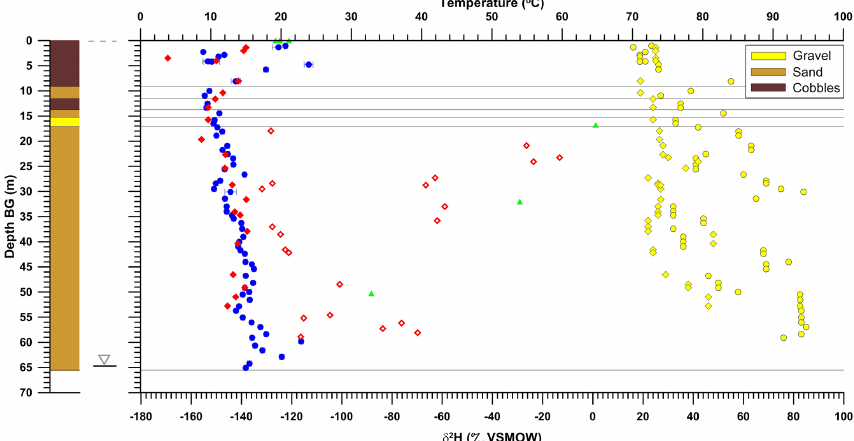
Figure 6. δ 2 H depth profiles of pore water from an unsaturated waste rock pile located in the Elk Valley, British Columbia. Samples collected via dry sonic coring are represented by solid blue circles, collected via wet sonic and not showing evidence of contamination (or minimally so) are represented by solid red diamonds, and collected via wet sonic and visibly contaminated by drill fluid are represented by open red diamonds. The δ 2 H values of the drill fluid samples are represented by solid green triangles. The temperatures of the core upon extraction are represented by solid yellow circles and solid yellow diamonds for the dry sonic and wet sonic samples, respectively. The location of the water table is identified by an inverted triangle. The mean gravimetric water content of samples from adjacent wet and dry sonic core samples from the unsaturated waste rock pile were 7.8 ± 1.5% ( n = 35) and 7.6 ± 2.0% ( n = 39),